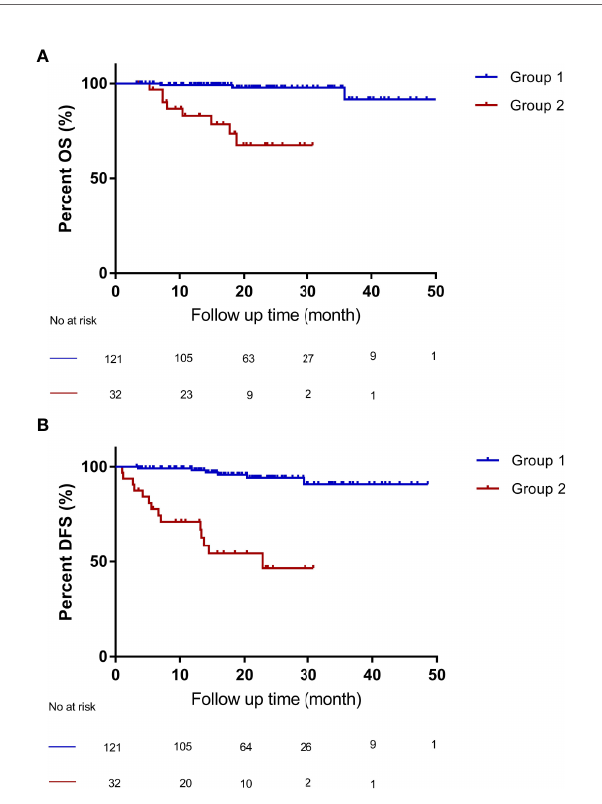
FIGURE 3 | Compared OS and DFS of patients with HCC who met “ Up-to- seven ” criteria and AFP of < 1000 ng/mL (group 1) and patients who did not meet “ Up-to-seven ” criteria or had AFP of > 1000 ng/mL (group 2). (A) patients within group 1 had better OS ( p < 0.001), with a 4-year OS of 91.6% than patients in group 2, with a 4-year OS of 67.5%. (B) patients within group 1 had better DFS ( p < 0.001), with a 4-year DFS of 90.8%, than patients in group 2, with a 4-year DFS of 46.5%. OS, overall survival; DFS, disease-free survival, HCC, hepatocellular carcinoma. Group 1 (n = 121): patients who met the “ Up-to-seven ” criteria and had AFP of < 1000 ng/mL; group 2 (n = 32): patients who did not meet “ Up-to-seven ” or had AFP of > 1000